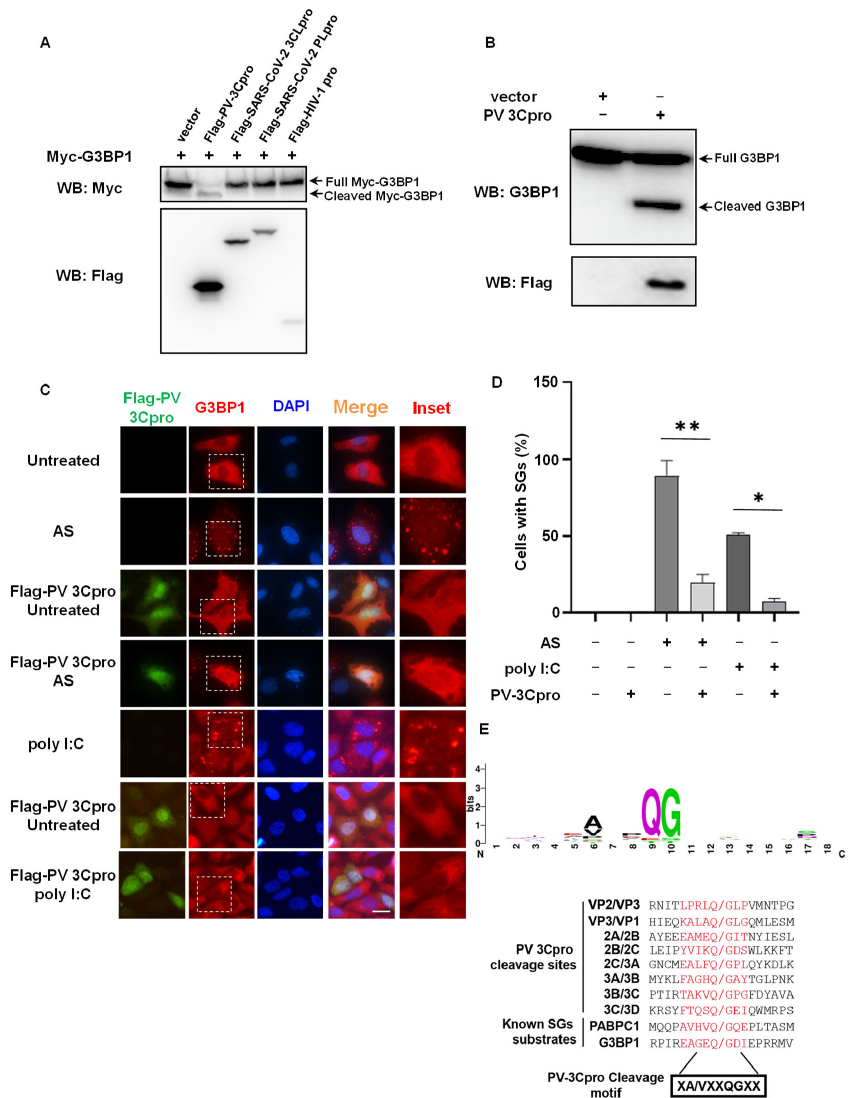
Figure 1. Cleavage of SG core protein G3BP1 by PV 3Cpro. ( A ) 293T cells were transfected with Flag-tagged viral proteases (PV 3Cpro, SARS-CoV-2 3CLpro and PLpro, HIV-1 pro) and Myc-G3BP1, followed by Western blot with anti-Flag and anti-Myc antibodies. ( B ) 293T cells were transfected with Flag-PV 3Cpro, followed by Western blot with anti-Flag and anti-G3BP1 antibodies. ( C ) HeLa cells were transfected with Flag-PV 3Cpro, and were untreated or treated with polyI:C for 9 h or 0.5 mM AS for 45 min followed by immunostaining for Flag (green) and G3BP1 (red). Scale bars: 20 µm. ( D ) Statistical analysis of the percentage of cells with SGs shown in panel ( C ). Data are shown as the mean ± SD ( n = 3). Statistics: Student’s t -test (*, p < 0.05, **, p < 0.01). ( E ) Sequence logo of PV 3Cpro cleavage sites generated from 8 sites of PV polyproteins and 2 sites of host proteins. Amino acids are color-coded according to their physicochemical characteristics. Polar, green; basic, blue; neutral, purple; acidic, red; hydrophobic, black. Amino acids are shown as one-le tt er standard code. Cleavage nomenclature is according to Berger and Schechter.